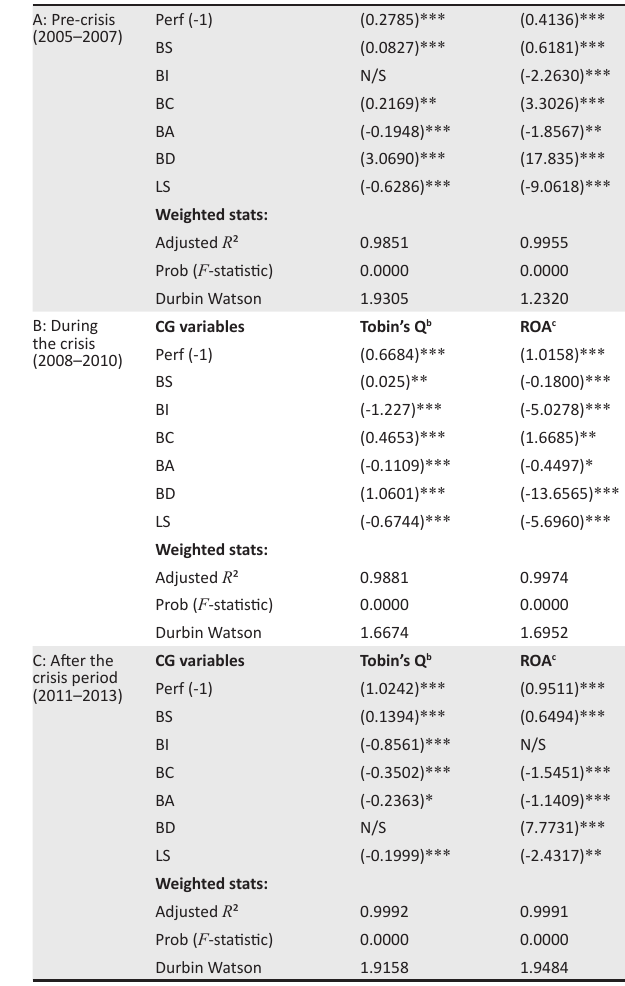
TABLE 2: Regression results of the impact of corporate governance attributes on Tobin’s Q and Return on Asset for the financials industry.